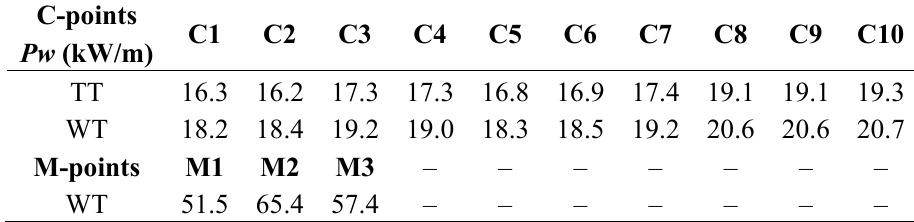
Table 6. Average values of the wave power: C-points, Canary Islands, structured, in total time (TT) and winter time (WT), respectively, data processed for the seventeen-year time interval 1996–2012; M-points, Madeira Archipelago (WT in kW over meter of wave front), representing the results of SWAN simulations performed for the time intervals (1997/10/07–1998/03/01) and